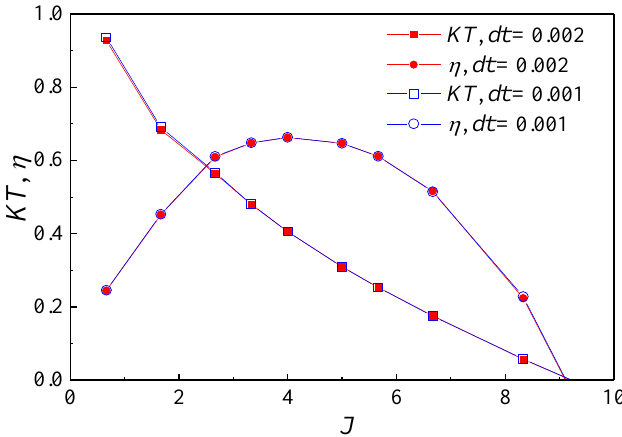
Figure 4. Comparison of propulsive performance with different time steps.